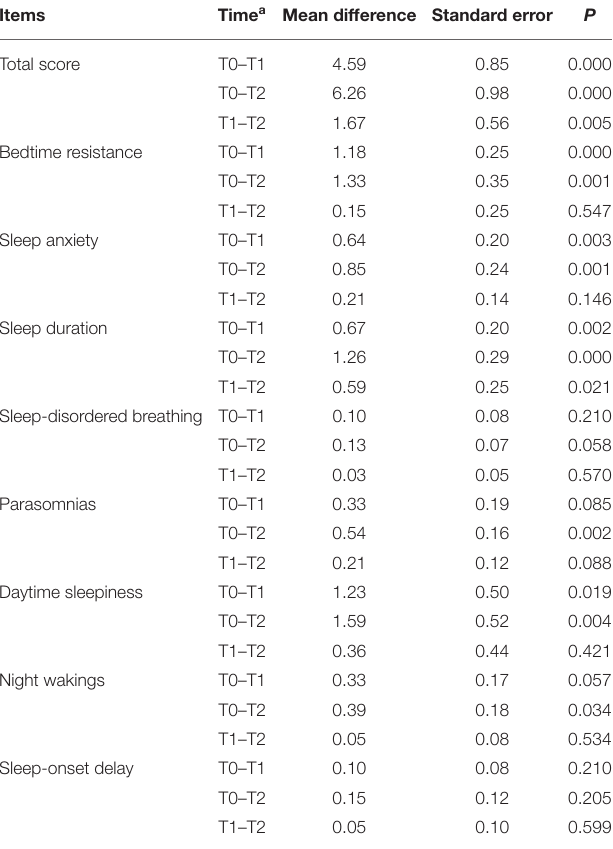
TABLE 2 | Comparison of CSHQ before and after intervention in children with autism spectrum disorder ( n = 39). Items